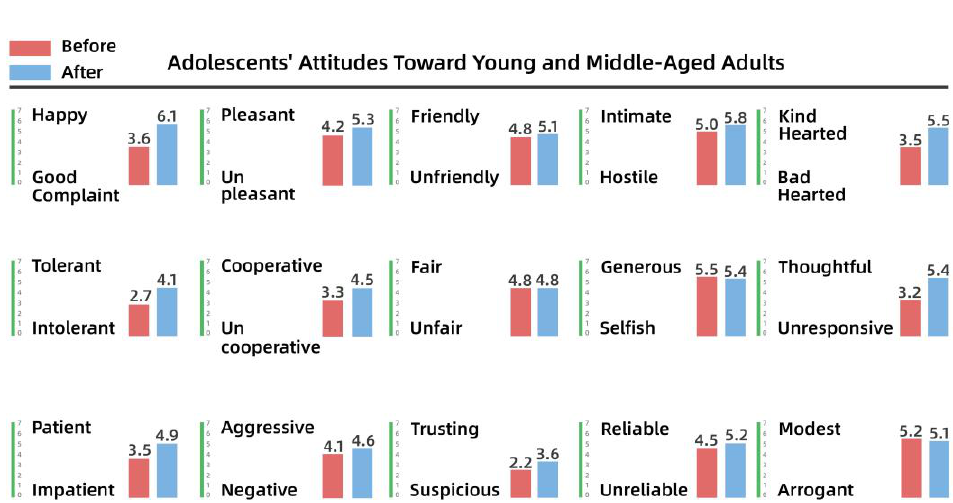
Figure 9. Adolescents’ attitudes toward older people. (2) Semantic scale results for young and middle-aged adults’ attitudes toward adoles- cents and older people